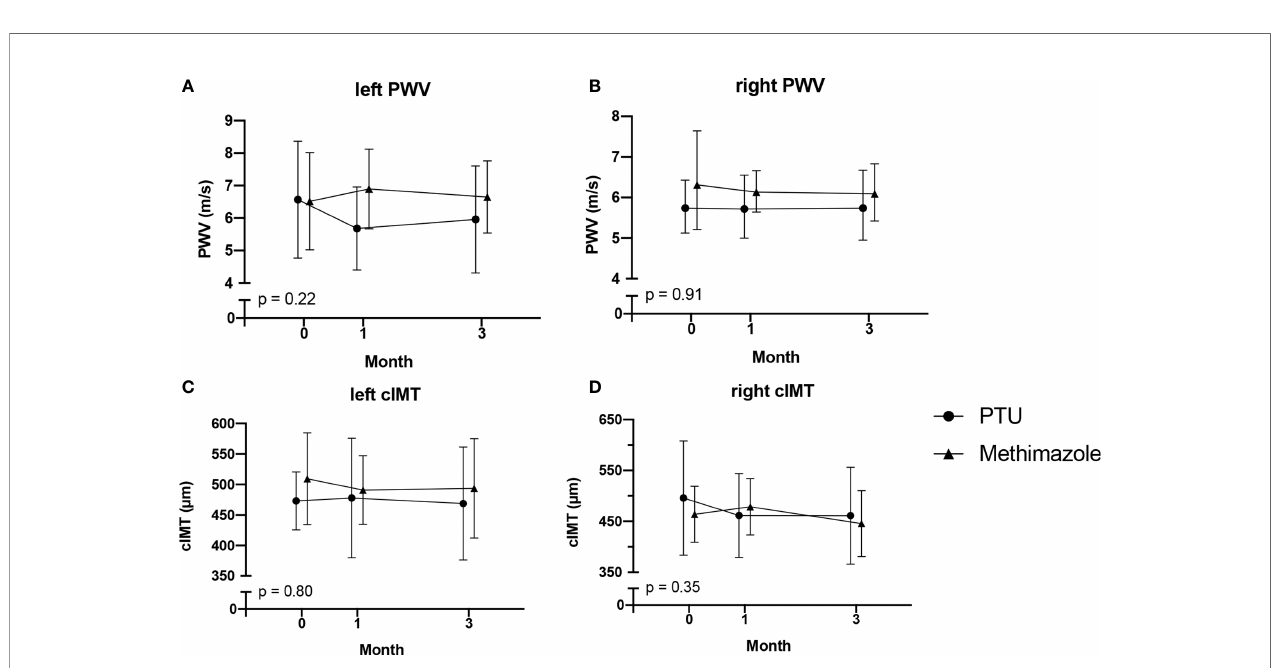
FIGURE 3 | Changes in PWV: (A) left PWV; (B) right PWV; and cIMT: (C) left cIMT; (D) right cIMT. After 3 months of antithyroid drug treatment. PWV, pulse wave velocity; cIMT, carotid intima media thickness. The comparisons were assessed using the general linear model